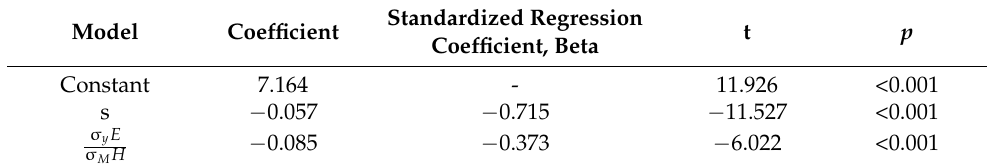
Table 16. Coefficients of the regression model for multi-asperity test.